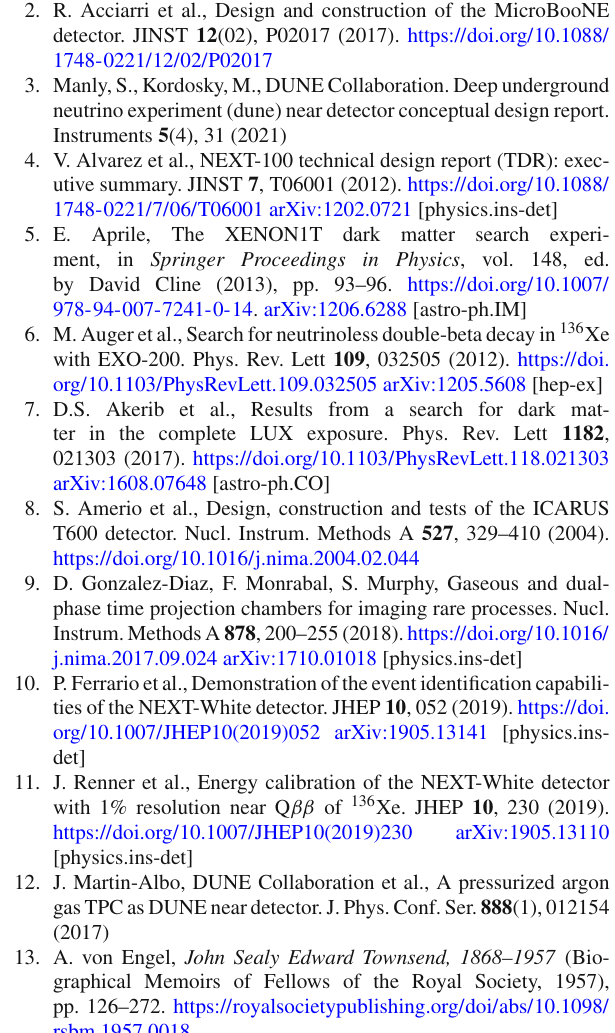
electric fields of ∼ 90 kV/cm over 1 cm-scale gaps; the insu- lating gases CO 2 and CF 4 are projected to support ∼ 170 and ∼ 210 kV/cm respectively. These dielectric strengths are very promising for the proposed applications as active gases and insulating gases in large, high pressure gas time projection